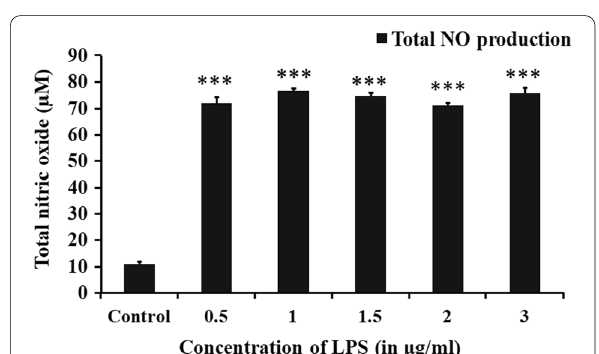
Fig. 5 LPS-induced total nitric oxide (TNO) production in RAW 264.7 cells. Cells were stimulated with the increasing (0.5, 1, 1.5, 2, and 3 µg/ml) concentrations of LPS for 24 h to determine the LPS dose for the study. The treated and untreated cell culture media were used to measure the amount of TNO to evaluate NO production. The level of TNO production in LPS stimulated cells were expressed as fold changes relative to the control group. All data are expressed as mean SEM (n 3). The values are statistically significant at * p < 0.05; ± = ** p < 0.01; *** p < 0.001 as compared to the control group